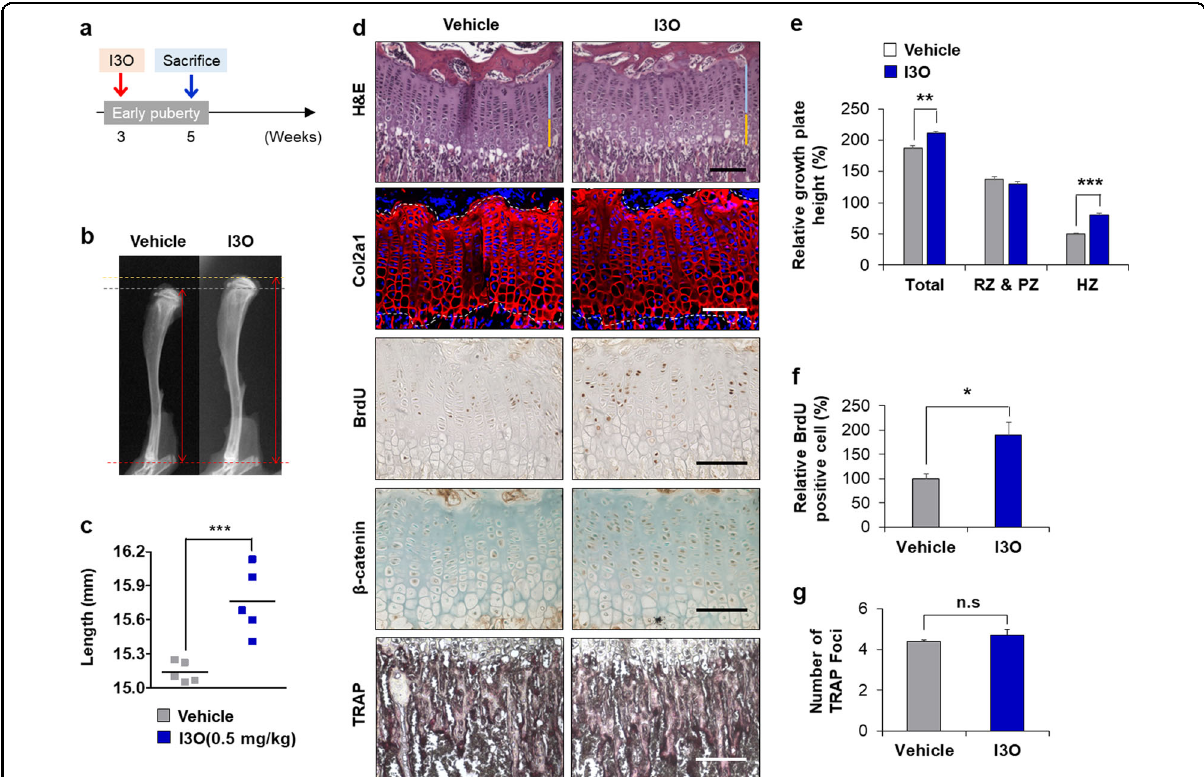
Fig. 4 The effects of I3O on the maturation of the mouse growth plate. a – g I3O (0.5 mg/kg) was administered to 3-week-old mice daily by intraperitoneal injection for 2 weeks. Schematic diagram of in vivo experiments a . Representative radiographs are shown b along with the tibial length measurements c (mean± s.e.m., n = 5 per group, *** P < 0.0005). The growth plates of proximal tibias treated or untreated with I3O underwent H&E staining, immunohistochemical analyses using the indicated antibodies, and tartrate resistant acid phosphatase (TRAP) staining for the osteoclast marker (dark purple) d . The area within the dashed lines indicates the growth plate zone. Scale bars, 0.1 mm. Quantitative analysis of height in the resting and proliferative zones (RZ&PZ) and the hypertrophic zone (HZ) (mean± s.e.m., n = 5 per group, ** P < 0.0005) e . Quantitative analysis of BrdU- positive cells in growth plates (mean± s.e.m., n = 5 per group, * P < 0.005) f . The number of TRAP-positive foci was quanti fi ed along the cartilage/ bone interface (mean ± s.e.m., n = 5 per group) g . n.s. indicates non-signi fi cance compared with